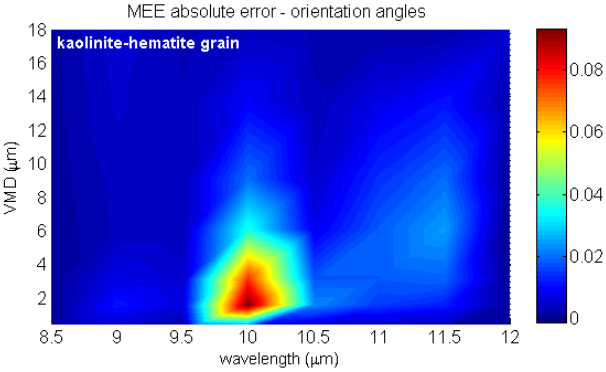
Figure 2 Absolute error in MEE between using a reduced number of orientation angles Fig. 2. Absolute error in MEE between using a reduced number (N=12) versus an extended set (N=1050) for an asymmetric kaolinite-hematite grain of orientation angles ( N = 12) versus an extended set ( N = 1050) mixture (units are in m 2 g -1 ). See text for details. for an asymmetric kaolinite-hematite grain mixture (units are in m 2 g − 1 ) . See text for details.